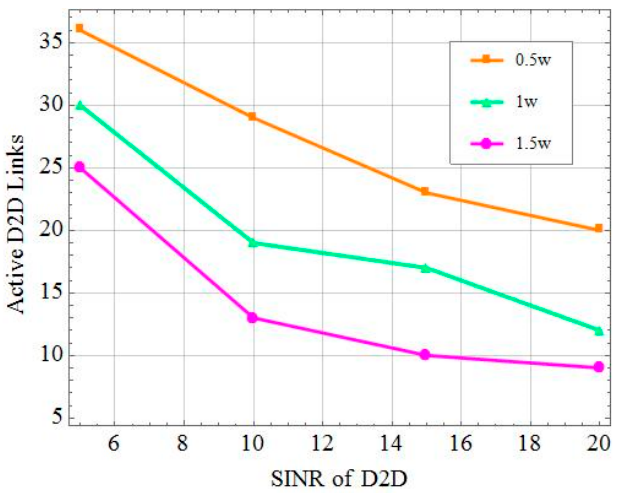
Figure 8. The impact of activity on device-to-device (D2D) links under different SINRs and different base station powers.